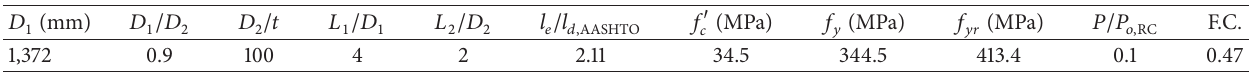
Table 1: Properties of the reference